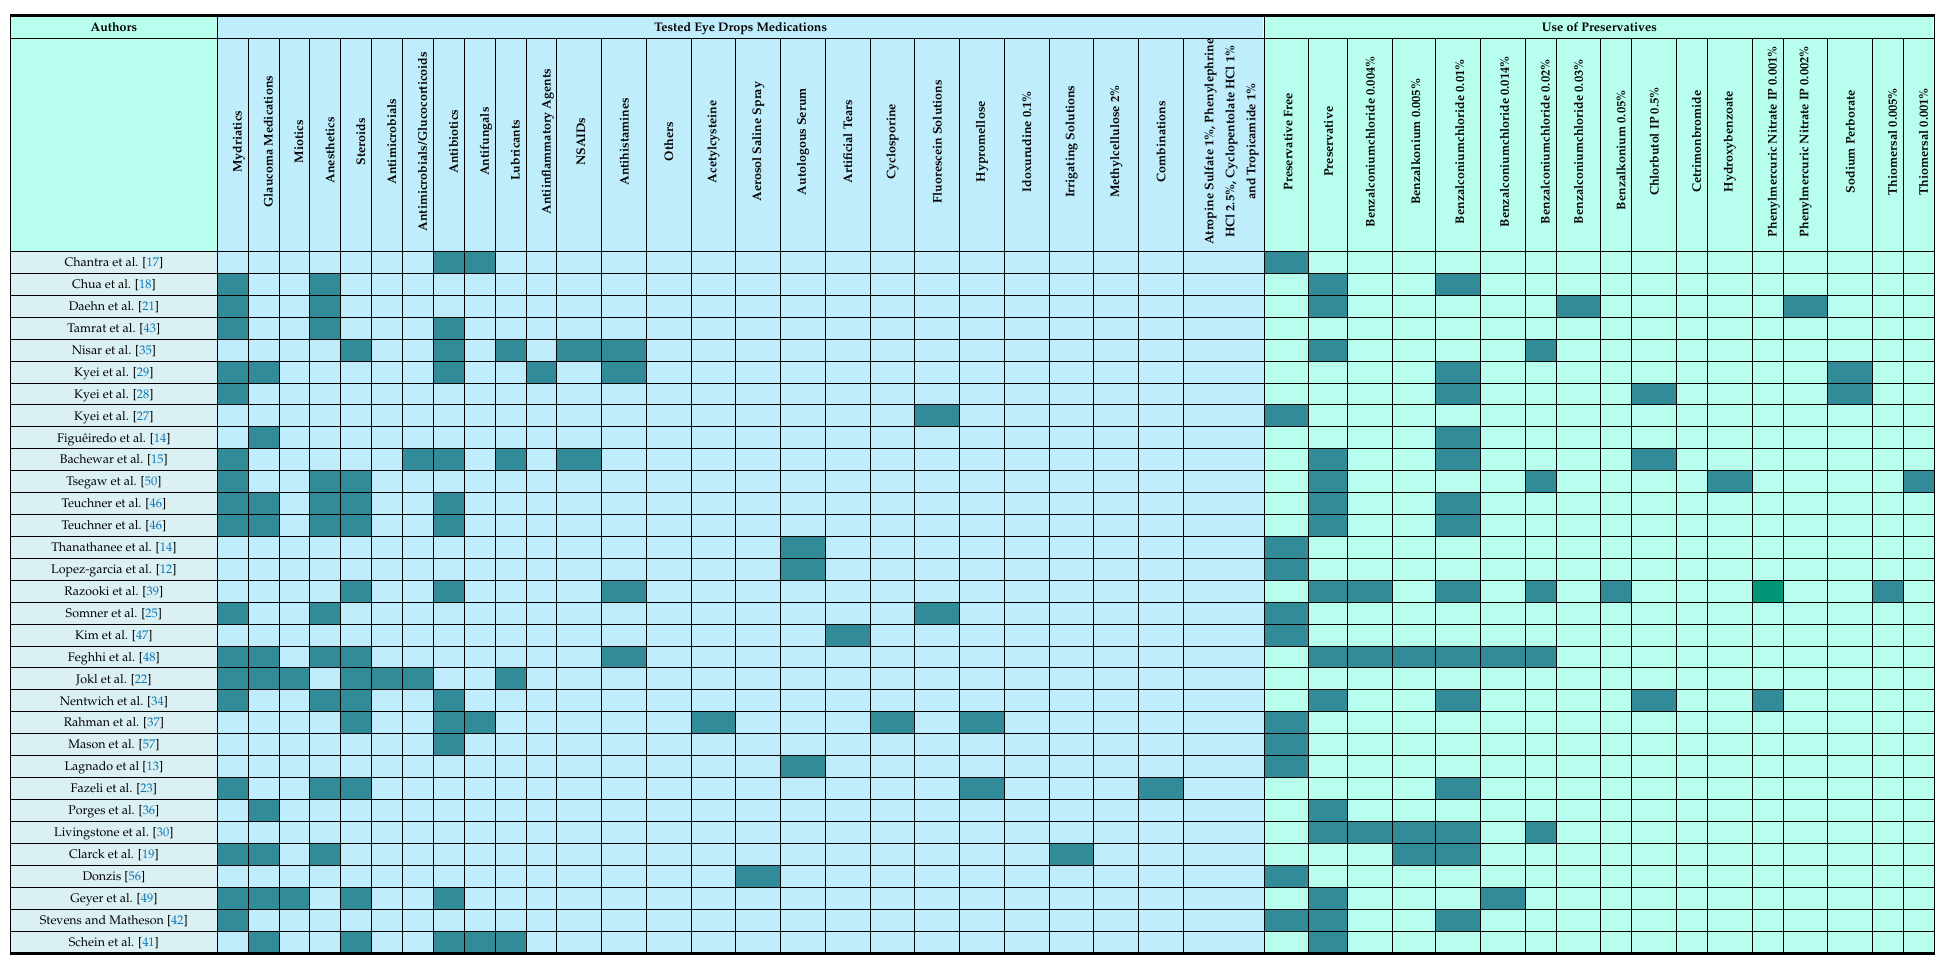
Table 3. Types of tested eye drop